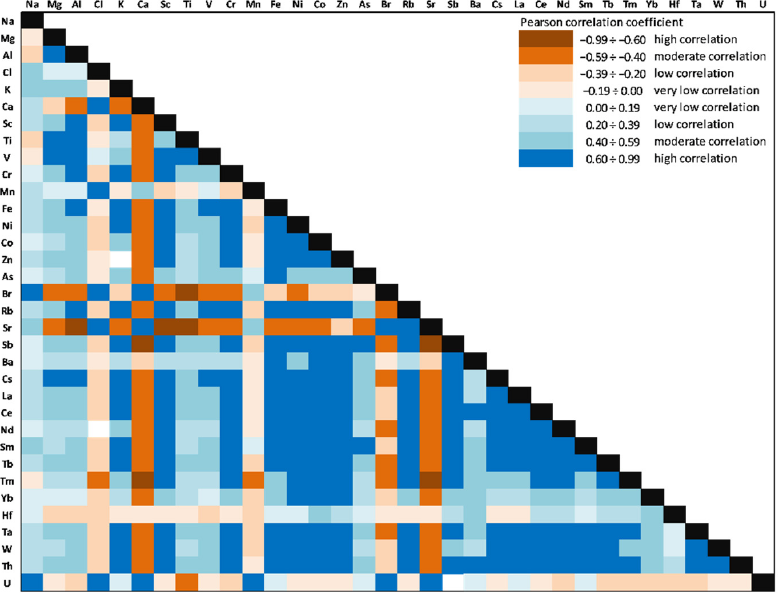
Figure 23. Pearson correlation map based on coefficient matrix for the relationship between the element concentrations in the Caineni Lake sediment core.